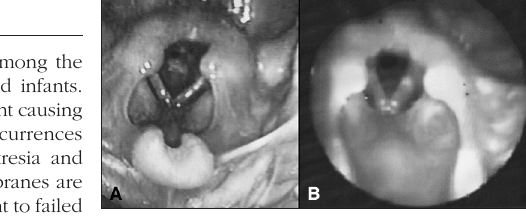
Figure 1. Laryngeal membrane in a child aged four months. A: Extensive laryngeal membrane producing tight evenly shaped round posterior glottic lumen; B: Endoscopic examination nine days after dilation procedure showing notable increase in glottic lumen despite remnants of congenital